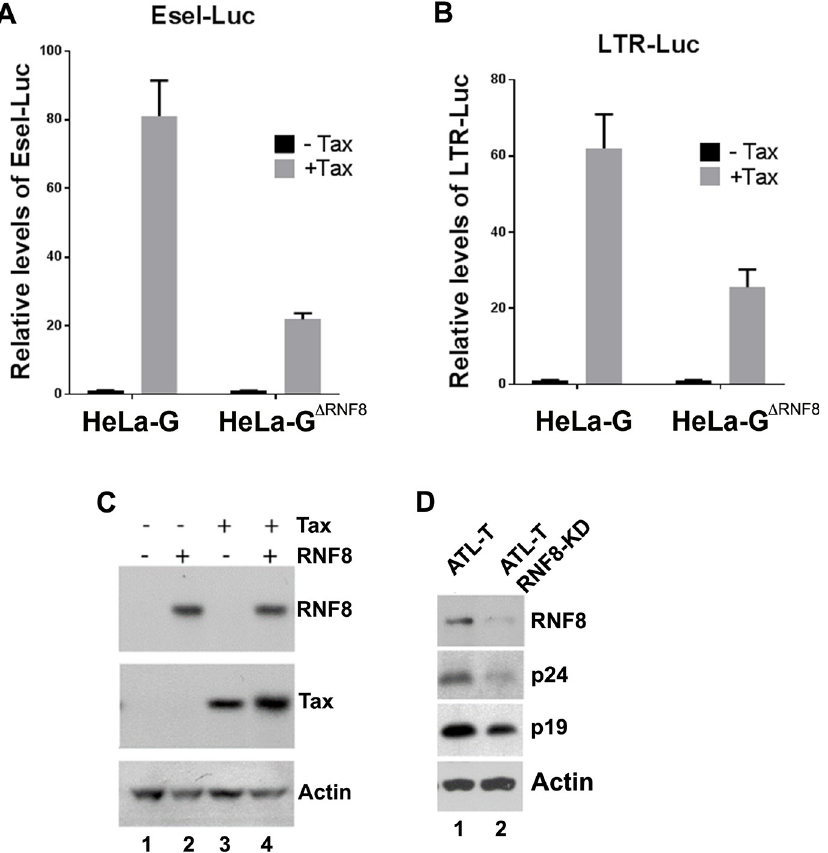
Fig 4. Loss of RNF8 reduces Tax-mediated LTR and NF- κ B activation, and viral protein expression. (A & B) NF- κ B luciferase reporter: E-selectin-Luc (Esel-Luc) or HTLV-1 LTR luciferase reporter: LTR-Luc was transfected into HeLa-G and HeLa-G Δ RNF8 cells in the presence or absence of Tax (50 ng) for 48 hrs. Luciferase activities and fold activation by Tax in RNF8-wildtype and RNF8-null cells were measured and calculated as previously described [15]. (C) Tax expression levels in transfected HeLa-G Δ RNF8 (lane 3) and HeLa-G (lane 4) cells were determined by immunoblotting. Un-transfected cells are included in lanes 1 and 2 as controls. (D) ATL-T and its progeny knocked down for RNF8 expression (ATL-T RNF8-KD) were immunoblotted for RNF8, HTLV-1 capsid and matrix proteins: p24 and p19, and β -actin.